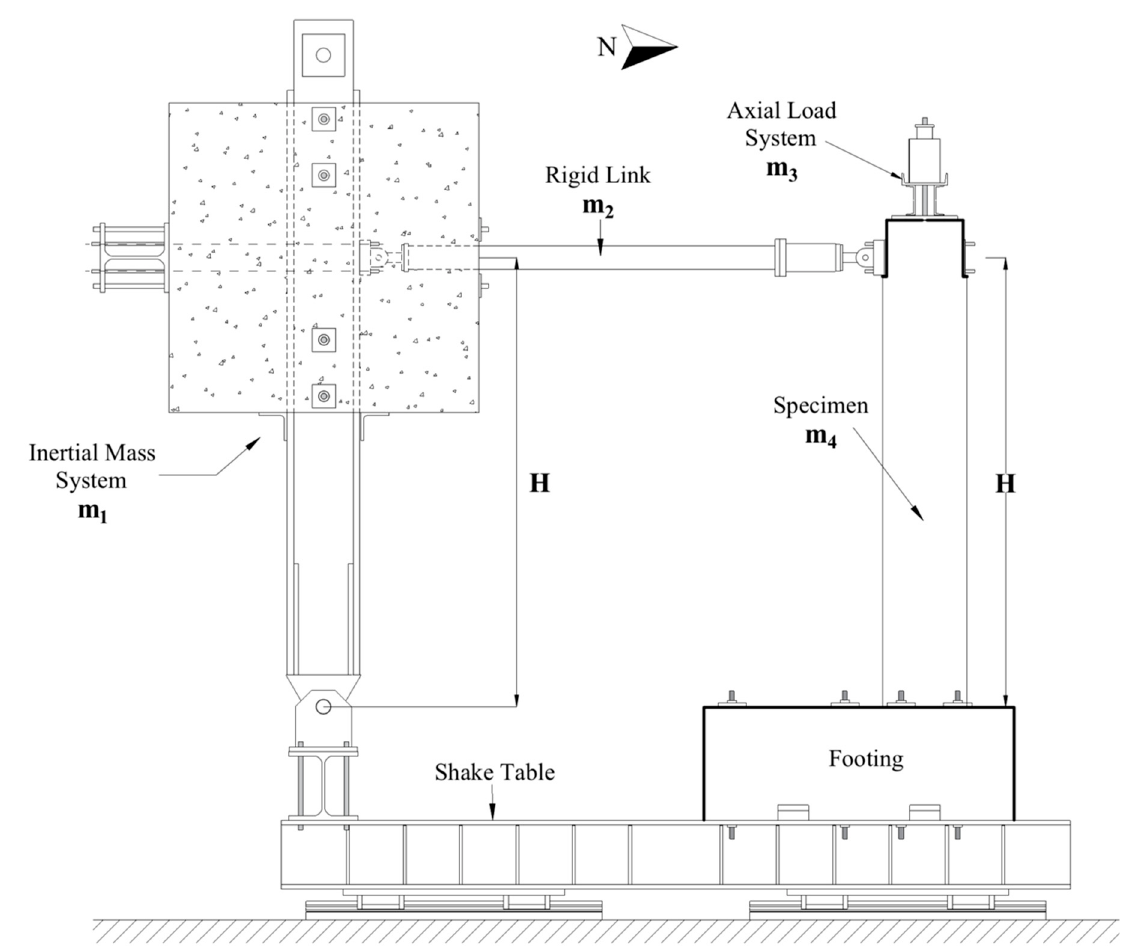
Figure 8. IMS mass locations.